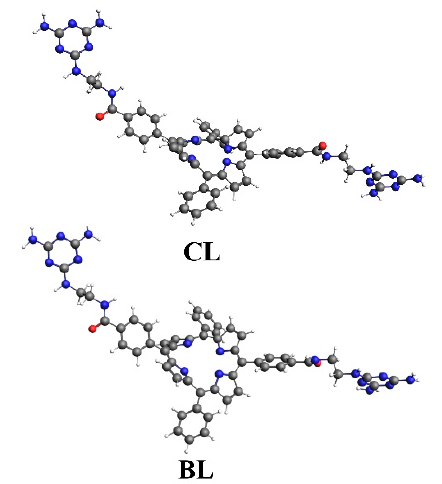
Figure 3. Optimized geometries of the chair-like (CL) and boat-like (BL) conformations.